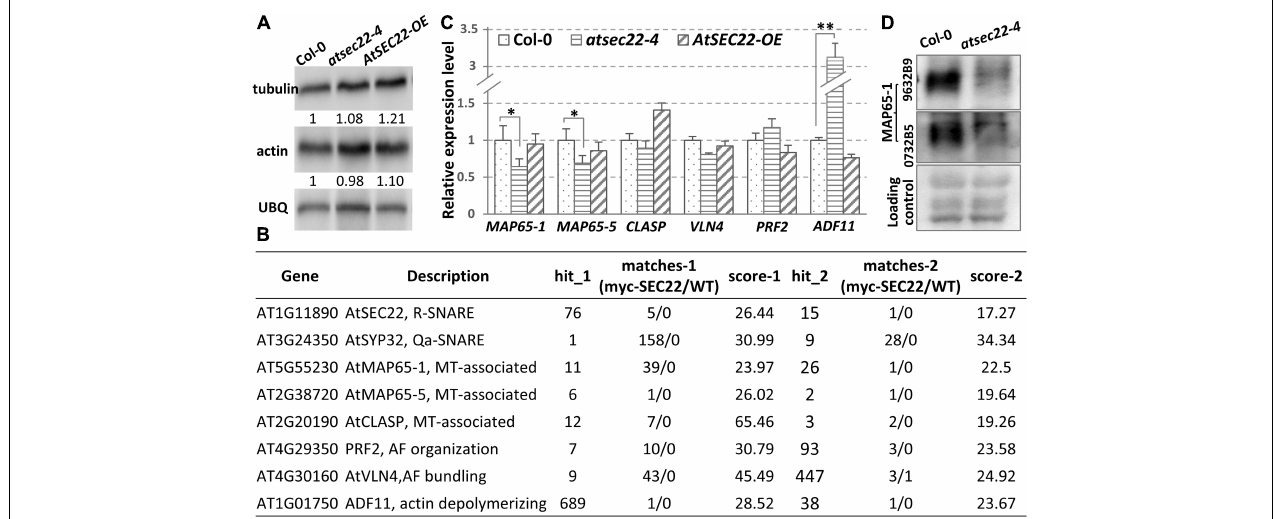
FIGURE 7 | Transcription levels of cytoskeleton-associated proteins were affected in atsec22-4. (A) Immunoblot analysis using ten-day-old seedlings with anti-actin and anti-tubulin antibodies. Ubiquitin (UBQ) was used as endogenous control. (B) LC-MS/MS identified cytoskeleton-regulators from pull down assay using myc- AtSEC22 -overexpressing plants. Hit_1, peptide_hit_number_1; score-1, peptide score-1; WT, Col-0. (C) Transcriptional levels of cytoskeleton-regulator genes. Two independent experiments for each sample, three replicates for each experiment. * P < 0.05, ** P < 0.01. Significance was evaluated by Student’s t test. (D) Protein levels of MAP65-1 were determined with two anti-MAP65-1 antibodies against two different peptides of MAP65-1 using ten-day-old